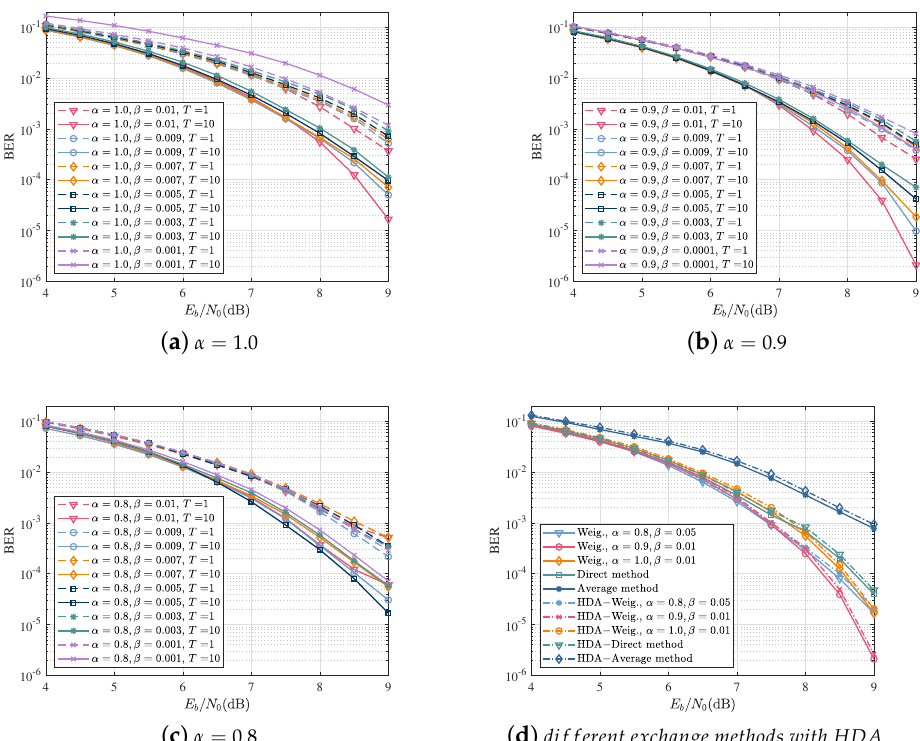
Figure 8. The performance of different exchange methods of extrinsic information with or without a stopping criterion. ( a ) BER as a function of E b / N 0 for α = 1.0; ( b ) BER as a function of E b / N 0 for α = 0.9; ( c ) BER as a function of E b / N 0 for α = 0.8; ( d ) BER as a function of E b / N 0 for different exchange methods of extrinsic information with the HDA stopping